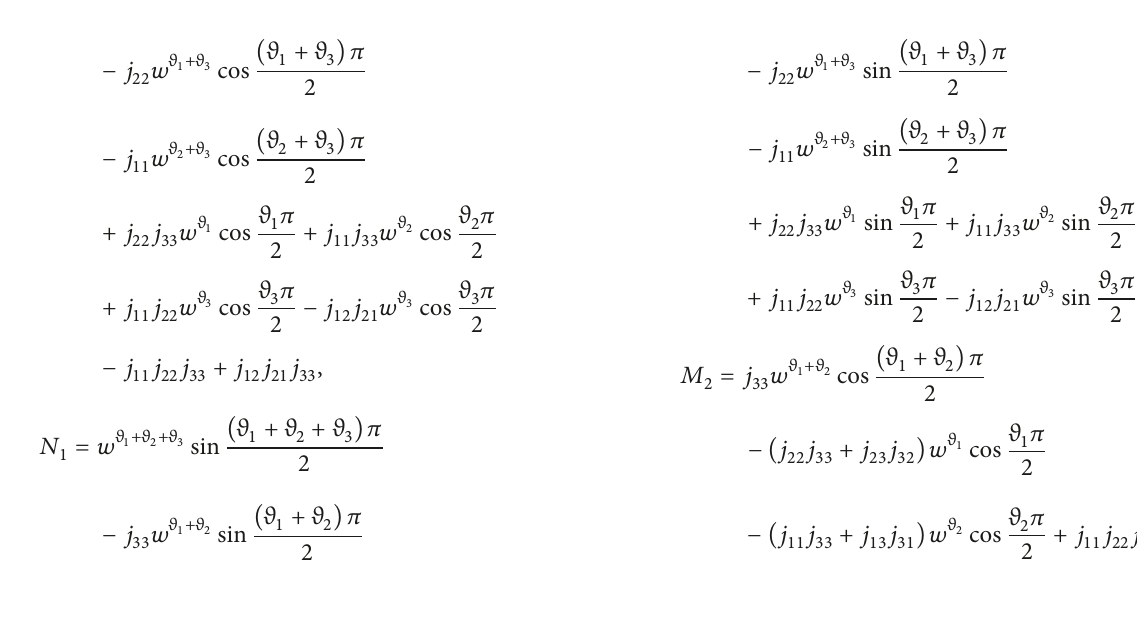
Figure 4: The effects of 𝑘 on the dynamical behaviors. The onset of bifurcation is negatively associated with 𝑘 which is shown in (a) and numerical simulation validates the theoretical results which is shown in